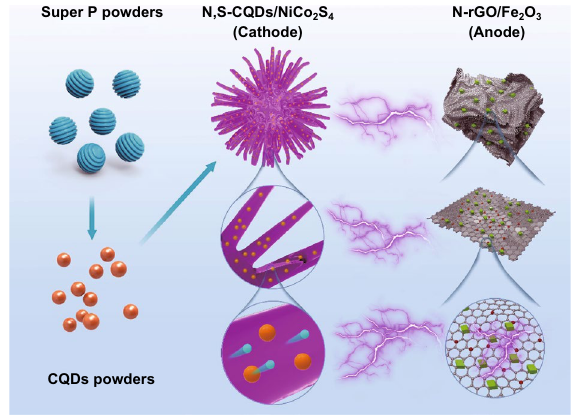
Fig. 1 Schematic illustration of the synthetic processes of the CQDs, the N,S‑CQDs/NiCo 2 S 4 composite cathode and N‑rGO/Fe 2 O 3 com‑ posite